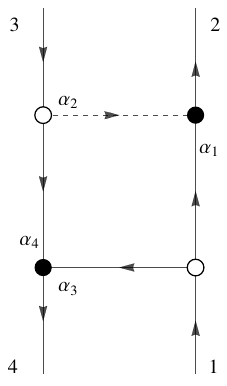
Figure 24 . On-shell diagram for 4-point seed